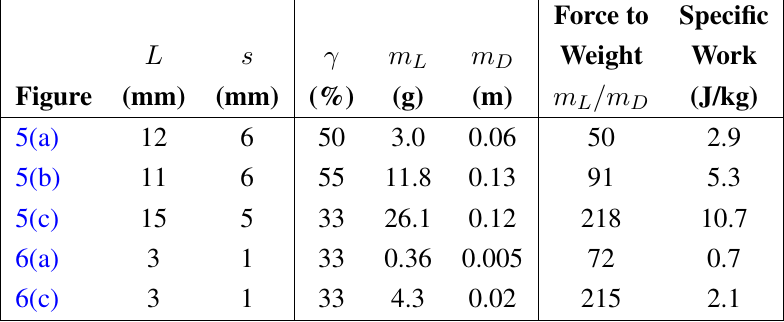
Table 2. Performance of linear actuator prototypes. Abbreviations used: device length in actuation direction without applied voltage, L ; actuation stroke, s ; actuation strain, γ ; load mass, m ; and device mass, m L D